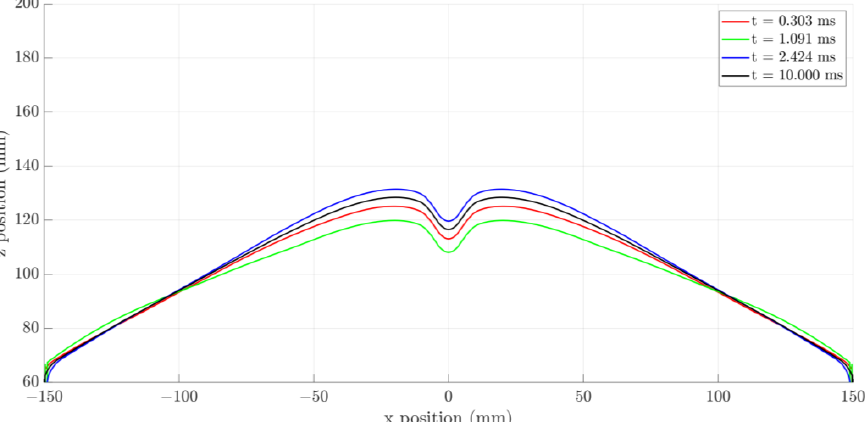
Figure 21. Simulated transient crosscut deformed profiles for a 120 ◦ V structure, 32 mm tip radius, subjected to a 20 g detonation.